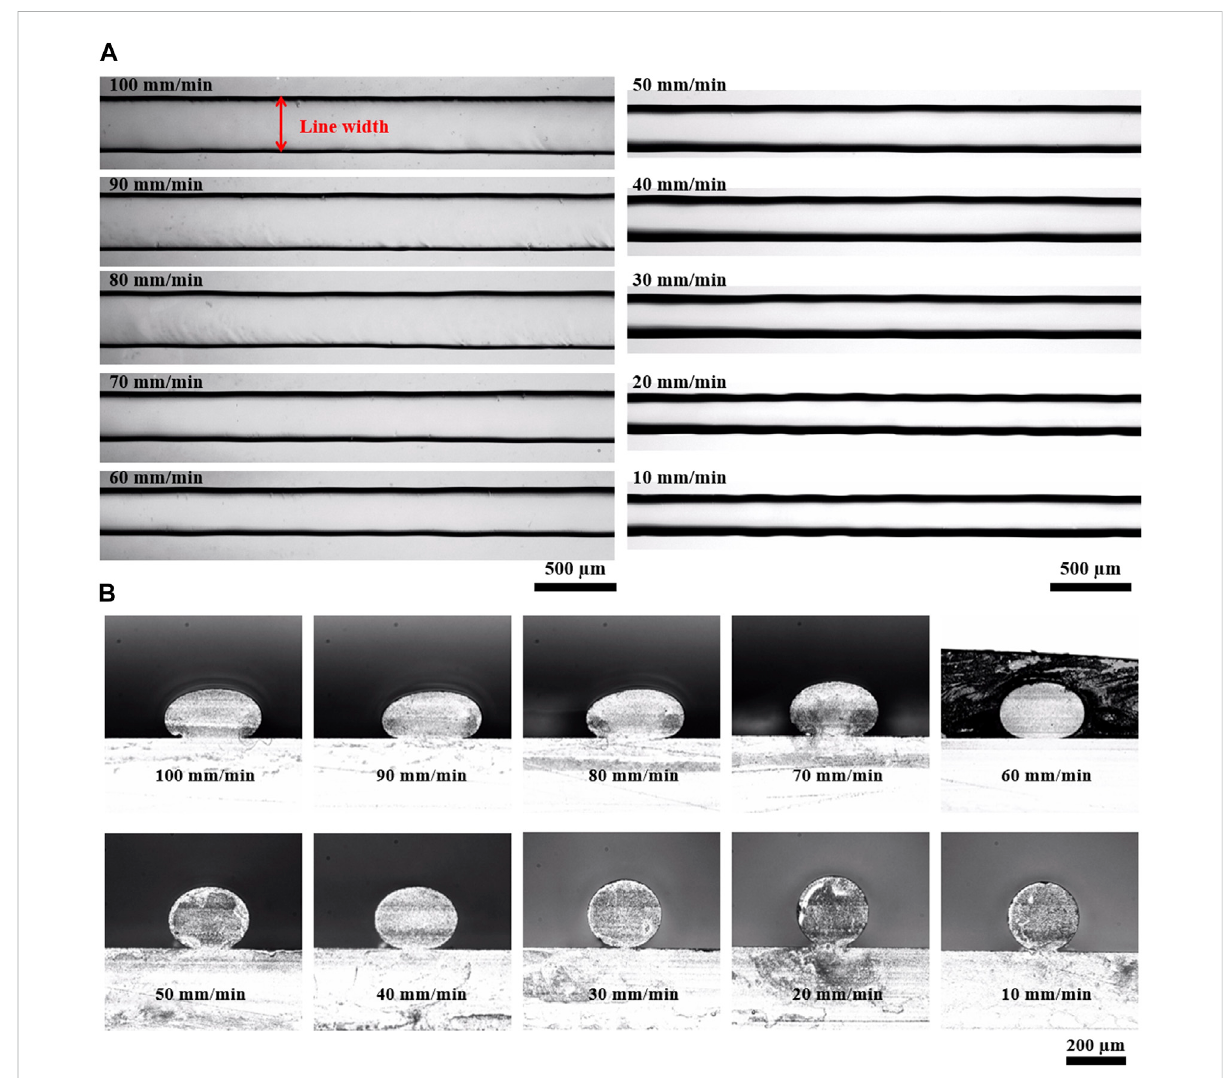
FIGURE 6 Top-view (A) , and cross-sectional images (B) of lines printed at 10 – 100 mm/min with corresponding laser power plotted in Figure